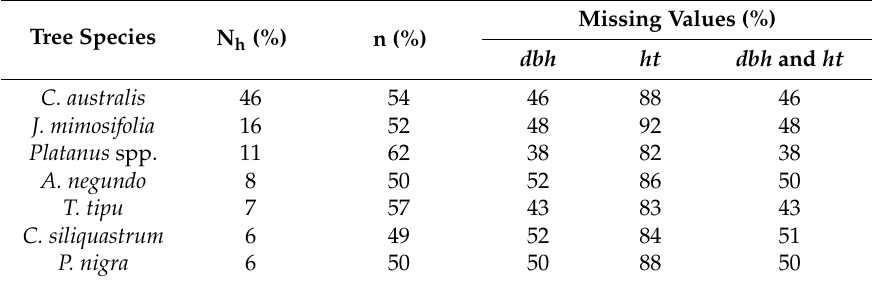
Table 4. Percentage of individuals for each tree species (N h ) and percentage of individuals (n) that were used for the imputation of missing values. Percentage of missing values for dbh , ht , and both dbh and ht